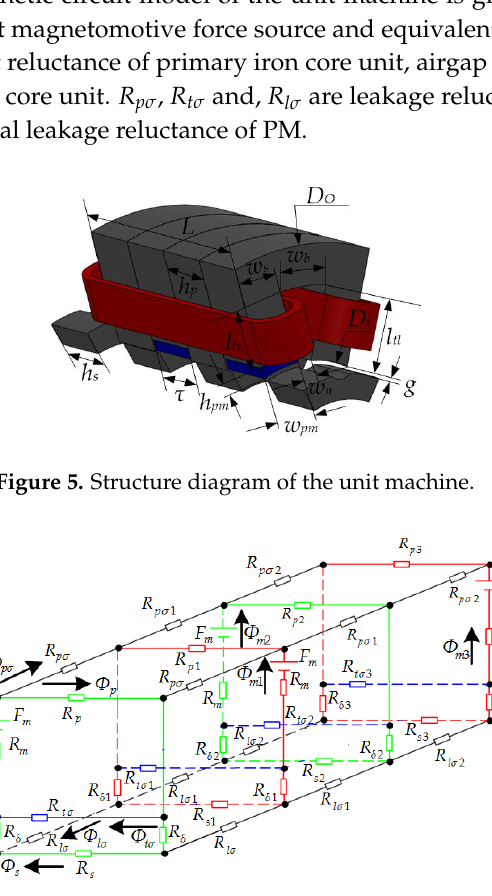
Figure 6. Equivalent magnetic circuit model of the unit machine.